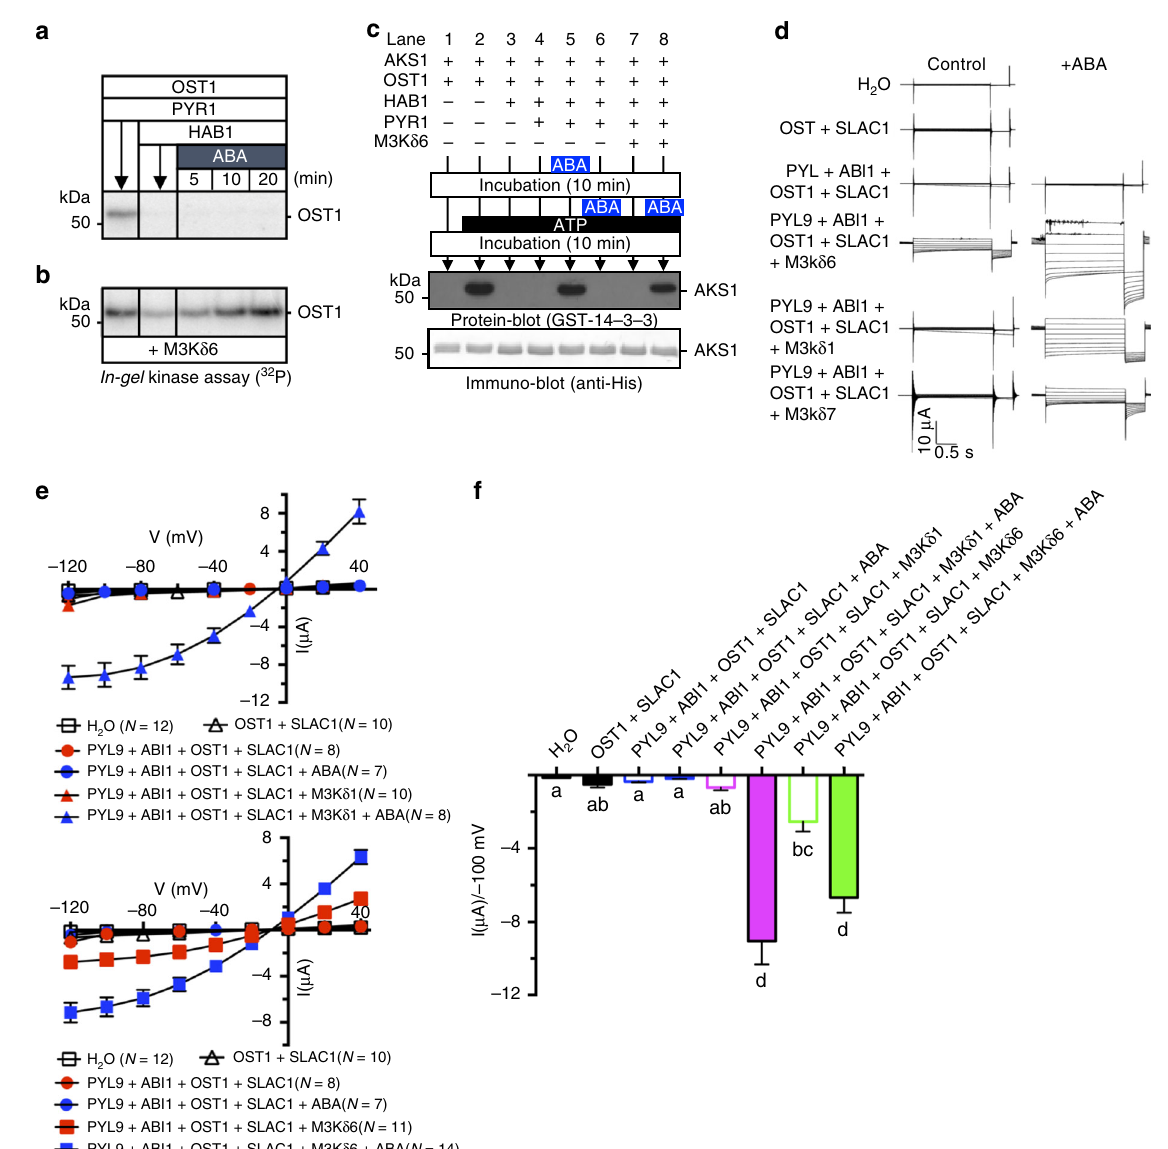
Fig. 4 MAPKK-kinases are essential for ABA signalling module. a , b In vitro reconstitution of ABA-induced OST1/SnRK2 activation without M3K δ 6 ( a ) or with M3K δ 6 ( b ). The recombinant proteins His-PYR1/RCAR11, His-OST1/SnRK2.6 without ( a ) or with ( b ) GST-M3K δ 6 kinase domain were mixed. After addition of His-HAB1, protein solutions were incubated for 10 min. Then, 50 µ M ABA was added to the protein solution. Reactions were stopped at the indicated times. OST1/SnRK2.6 kinase activities were detected by in-gel kinase assays. c Recombinant His-PYR1/RCAR11, His-HAB1, His-OST1/SnRK2.6, His-AKS1, and GST-M3K δ 6 kinase domain were mixed as indicated above the gel. 50 µ M ABA was added before (lane 5) or after (lanes 6 and 8) 10 min incubation at room temperature. Then, 100 µ M ATP was added (lanes 2 – 8) to trigger phosphorylation reactions for 10 min. Note that M3K δ 6 is required for ABA-induced AKS1 phosphorylation when ABA is added 10 min after exposure to HAB1-PP2C-including mix (compare lanes 6 and 8). Reactions were stopped by addition of SDS-PAGE loading buffer. Phosphorylation of AKS1 is detected by binding of 14-3-3Phi (At1g35160) to the phosphorylated AKS1 protein 15 . AKS1 phosphorylation is shown by protein-blot (top), and protein amount is monitored by immuno-blot (bottom). d – f Reconstitution of ABA- activation of SLAC1 channels in Xenopus oocytes, in the presence or absence of M3Ks. d Representative whole-cell chloride current recordings of oocytes co-expressing the indicated proteins, without (control) or with injection of 50 μ M ABA ( + ABA). Currents were recorded in response to voltage pulses ranging from + 40 mV to − 120 mV in − 20 mV steps with a holding potential at 0 mV and a fi nal tail potential of − 120 mV. e Mean current-voltage curves of oocytes co-expressing the indicated proteins, with or without injection of ABA. The symbols of H 2 O control, OST1 + SLAC1, PYL9/RCAR1 + ABI1 + OST1 + SLAC1, PYL9/RCAR1 + ABI1 + OST1 + SLAC1 + ABA, and PYL9/RCAR1 + ABI1 + OST1 + SLAC1 + M3Ks overlapped. Single symbols are shown for some data points for better viewing. f Average SLAC1-mediated currents at − 100 mV, co-expressing the indicated proteins, in the presence or absence of 50 μ M ABA. Data from three independent batches of oocytes showed similar results. One representative batch of oocytes is shown, with the number of oocytes in that batch indicated in parentheses. H 2 O, OST1 + SLAC1, PYL9/RCAR1 + ABI1 + OST1 + SLAC1, and PYL9/RCAR1 + ABI1 + OST1 + SLAC1 + ABA controls are the same data in both panels in e as the data are from the same oocyte batch. Error bars denote mean ± s.e.m. Means with letters ( a , b , c , and d ) are grouped based on one-way ANOVA and Tukey ’ s multiple comparisons test, P <